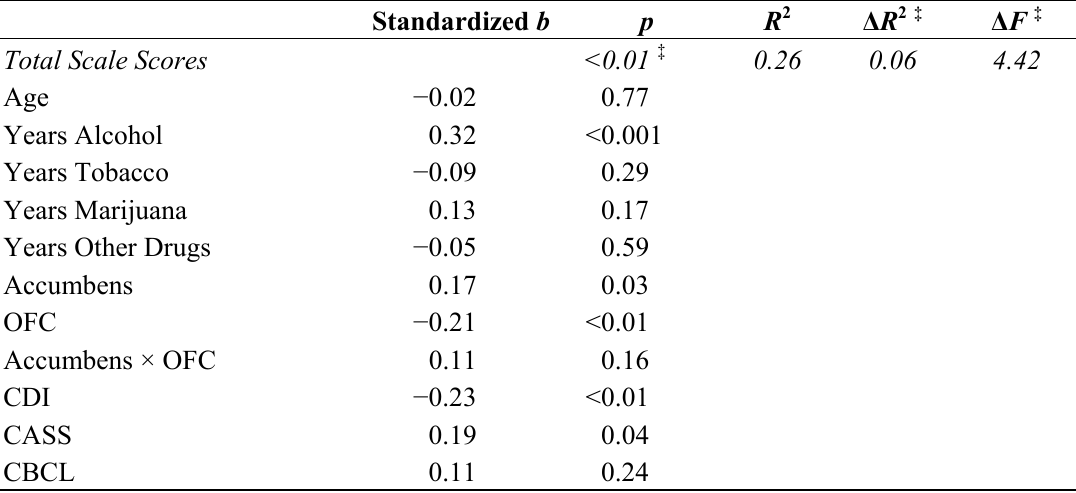
Table 3. Overall follow-up hierarchical regression models of frequency of alcohol